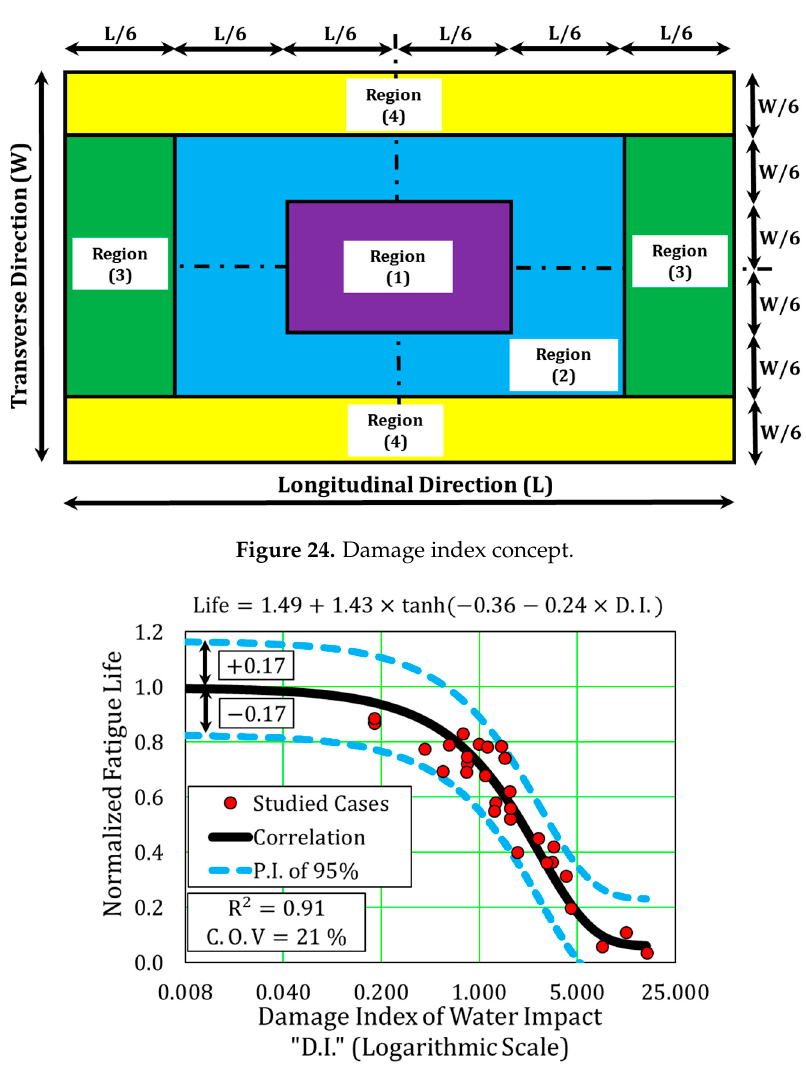
Figure 25. Relation of the damage index of water impact and the normalized fatigue life.